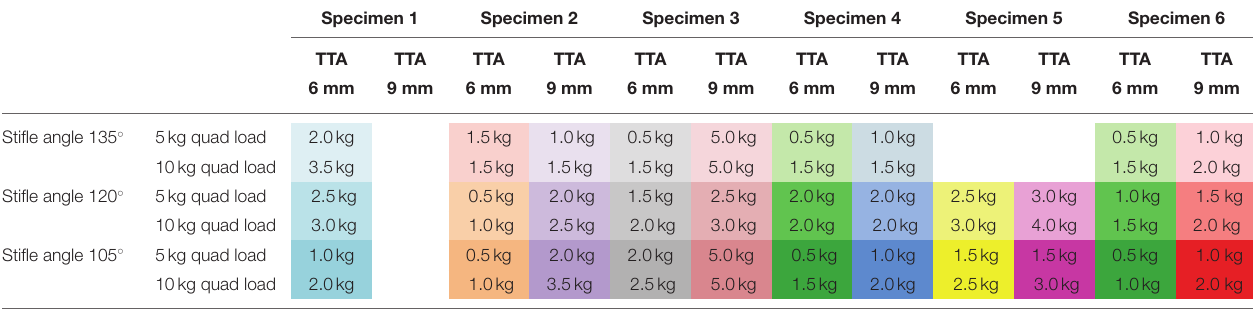
Color added for emphasis.